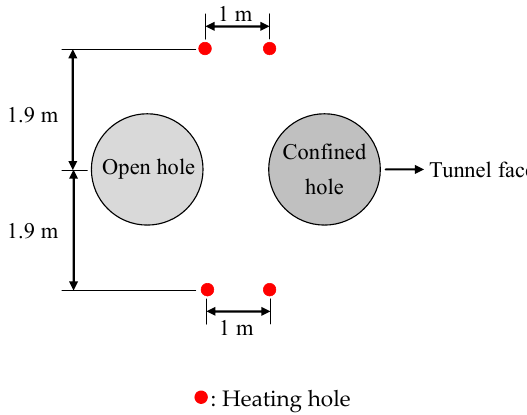
Figure 2. General layout of the two vertical holes and heating holes [20].